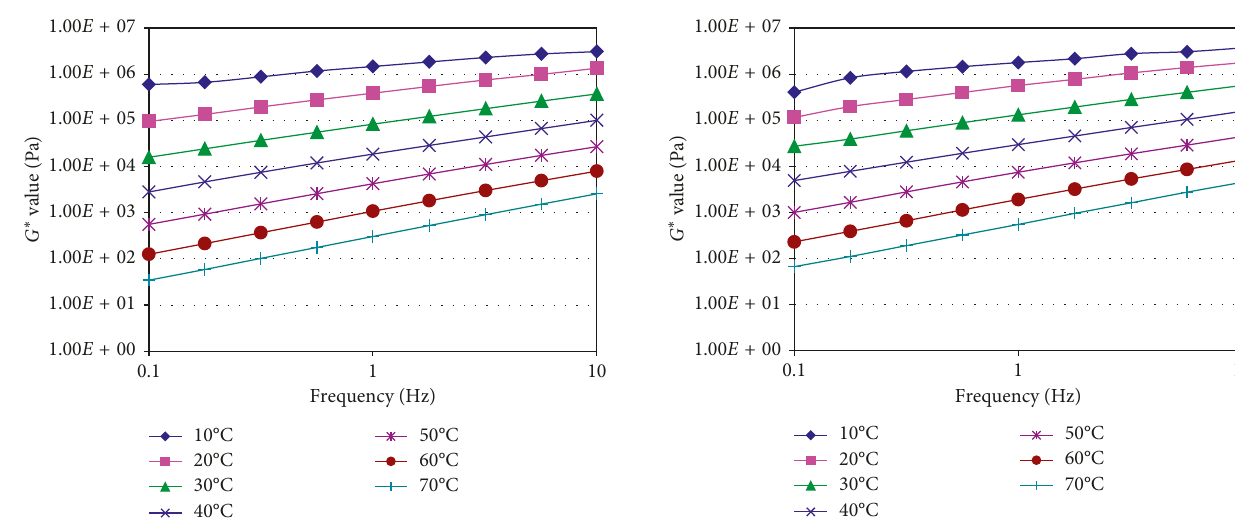
Figure 13: G value versus loading frequency for the control asphalt binder. ∗